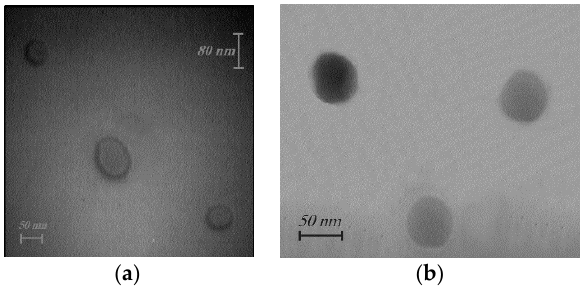
Figure 1. TEM pictures of prepared DTX-loaded nanomicelles of formulation I ( a ) and formulation III ( b ).